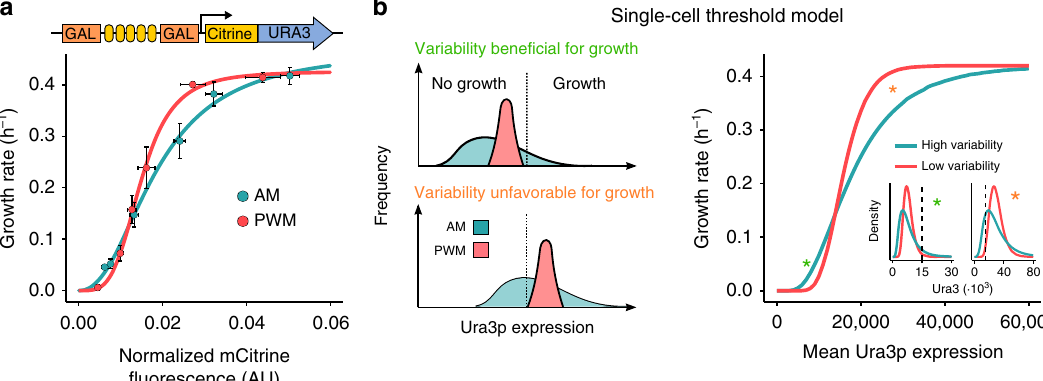
Fig. 5 Effect of regulating URA3 expression levels by AM and PWM on cell growth. a Cells expressing mCitrine-tagged Ura3p from the 5xBS- GAL1 pr were grown under AM (blue) and PWM (red) light induction for 14 h in media with uracil before transfer to uracil-free media, fl uorescence, and growth measurements. PWM was performed with a 30 min period and 420 µ W cm − 2 light intensity. Growth was measured for 5 h. Hill functions were fi t to the data for comparison and guidance (see Supplementary Fig. 14f and Supplementary Table 7 for parameters). The effect of AM and PWM on the CV is shown in Supplementary Fig. 14c. Data represent the mean and s.e.m of three independent experiments. Data of all individual experiments are shown in Supplementary Fig. 14d, e. b The experimental data are consistent with an all-or-none growth response to Ura3p expression on the single-cell level (threshold model). A schematic representation illustrating how cell-to-cell variability combined with a threshold expression level required for growth (dashed line) may affect cellular growth for two different expression levels is shown on the left. For low mean expression levels, expression variability enables growth of a small subpopulation. In contrast, for high expression levels, cell-to-cell variability may lead to a subpopulation that is unable to grow and a subpopulation with unnecessarily high expression levels. The expected relation between mean expression levels and growth rate for the threshold model is shown on the right. Growth rates were calculated by computing the fraction of log-normal distributions with values higher than a threshold level (15,000) and multiplying the resulting fraction by the maximal growth rate of 0.42 h − 1 . The CV of the log-normal distributions used was 0.6 for the high variability curve (blue) and 0.3 for the low variability curve (red). The insets show the distributions for mean expression levels marked by asterisks in the main fi gure together with the growth threshold value (dashed line) NATURE COMMUNICATIONS| (2018) 9:3521 |DOI: